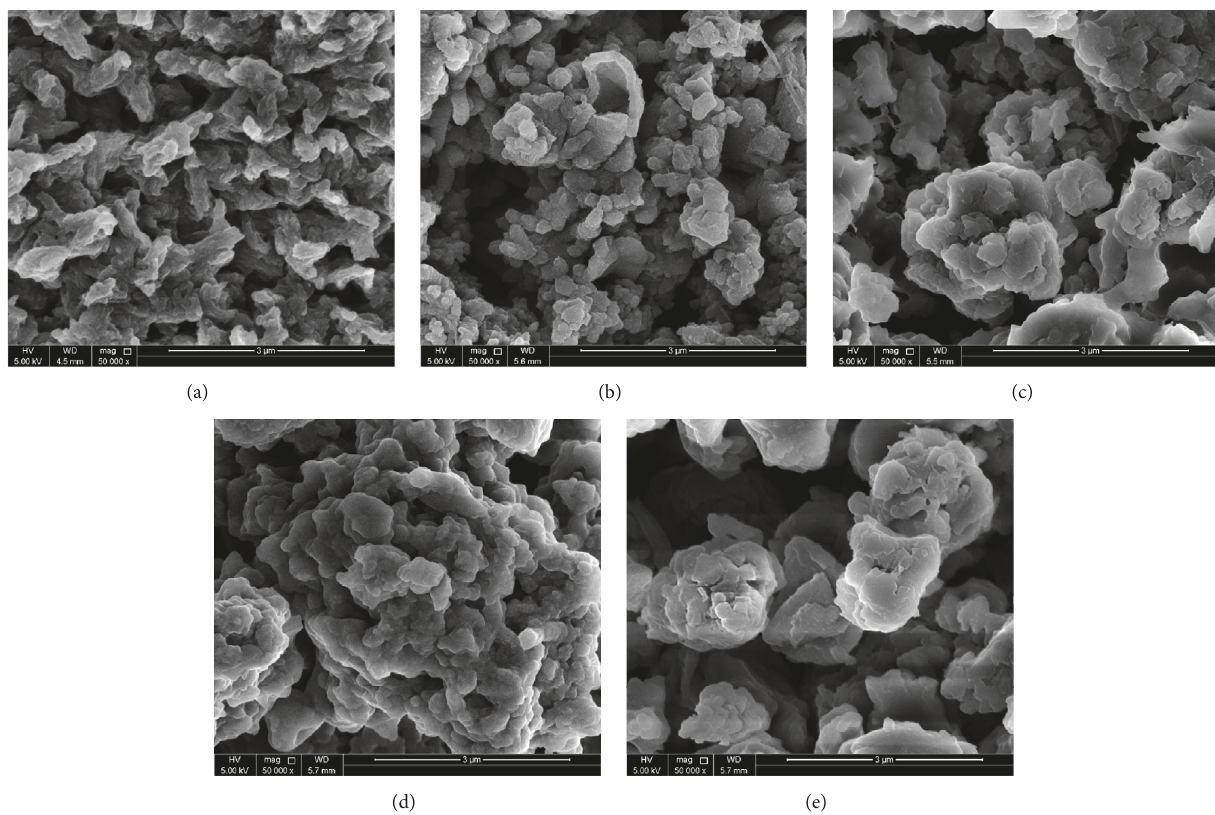
Figure 7: SEM images of pure PANI and CSA-doped PANI-PS blends. (a) Pure PANI, (b) PANI-PS 0.2 M CSA, (c) PANI-PS 0.3 M CSA, (d) PANI-PS 0.4M CSA, and (e) PANI-PS 0.5 M CSA.